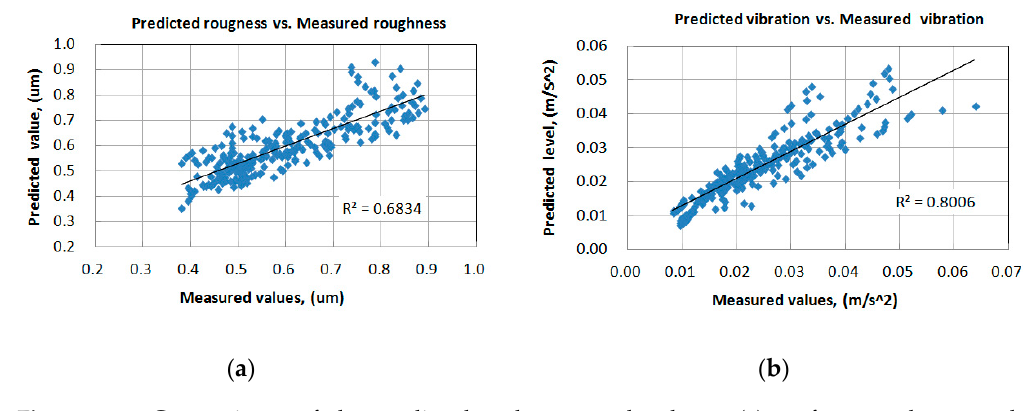
Figure 12. Comparisons of the predicted and measured values: ( a ) surface roughness and ( b )